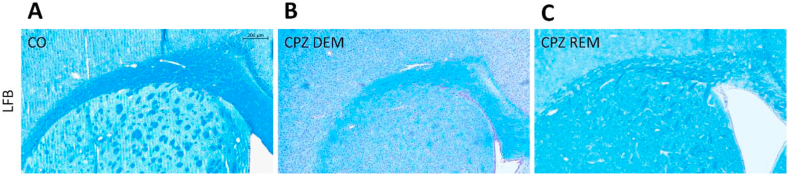
LFB staining in the corpus callosum of the CO- (A), DEM- (B) and REM (C) group. The CPZ-treated group (B) showed a reduced myelin content compared to the CO group (A), which increased during the remyelination phase (C). Scale bar: 200 μm. CO control group, CPZ cuprizone treated group, DEM demyelination phase in the treated group, LFB Luxol Fast Blue, REM remyelination phase in the treated group.